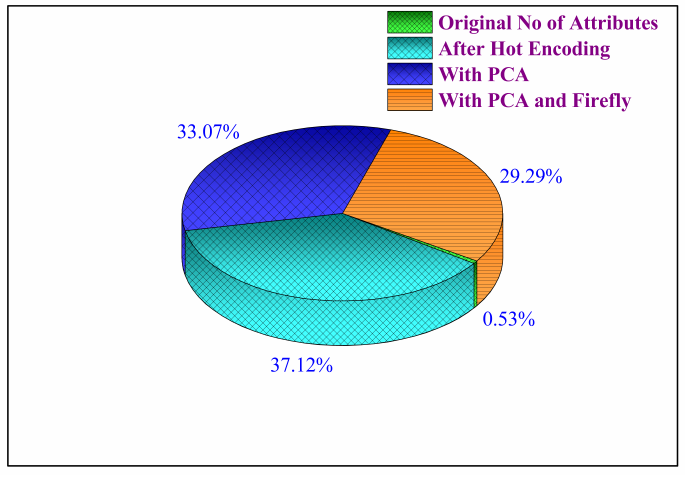
Figure 3. Number of attributes.